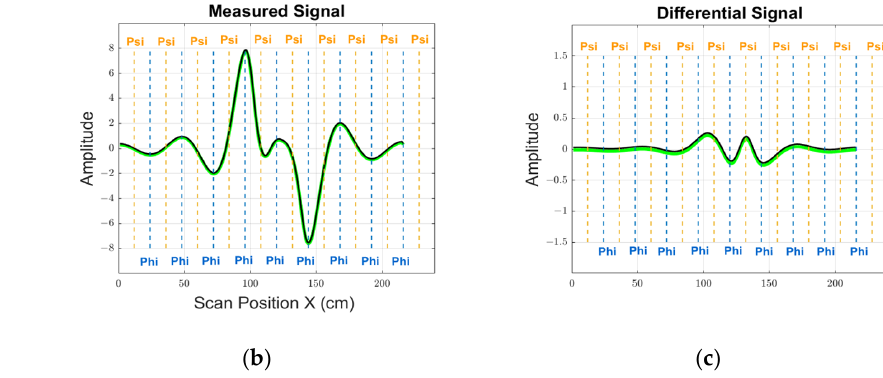
Figure 5. Measured object with perturbations and simulated receiver signals. The signals are calculated by the dot product of the currents and vector potentials (green line) and by the dot product of the magnetic dipole moments and flux densities (black line, small offset applied for better visibility). Vertical and dashed lines indicate the positions Phi (blue) and Psi (orange); ( a ) Measured object with perturbations; ( b ) Total signals with disturbances; ( c ) Differential signals calculated by the difference between a total signal with and without perturbations.